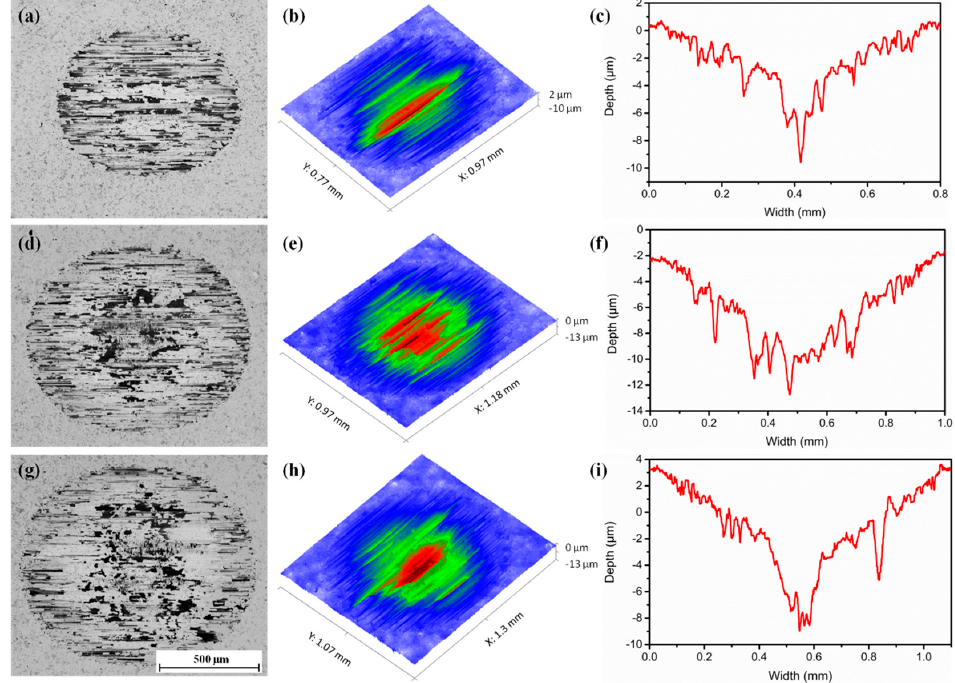
Figure 10. Plan view SEM-BSE images of the wear scars and their corresponding 3D surface morphologies and cross-sectional profiles under the normal load of 70 N after fretting cycles of 24 × 10 3 ( a – c ), 48 × 10 3 ( d – f ), and 72 × 10 3 ( g – i ).